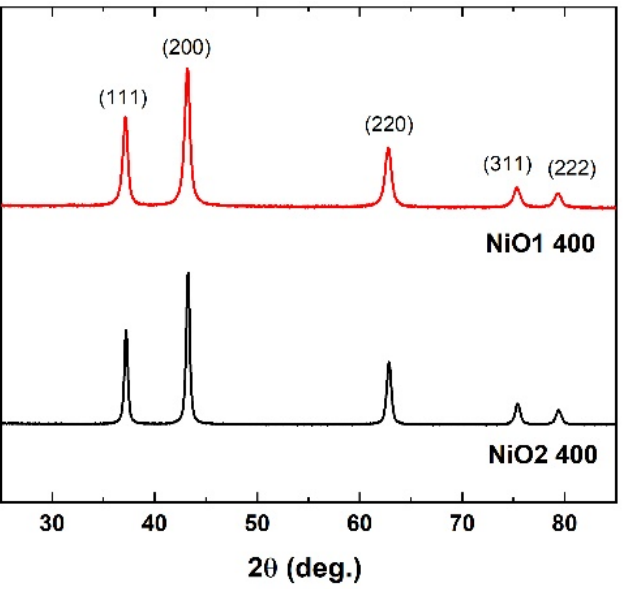
Figure 2. XRD patterns of the NiO samples, indexed with the fcc structure according to ICDD—01-071-1179. Broader XRD peaks are observed for NiO1 400 with respect to the peaks of NiO2 400, suggesting a lower crystallinity degree of the corresponding nanoparticles. Indeed, the Rietveld analysis determined the volume averaged crystallite size d = 11 ± 2 nm for NiO1 400 and d = 19 ± 2 nm for NiO2 400. The same lattice parameter a = 0.4178 ± 0.0001 nm was calculated for both